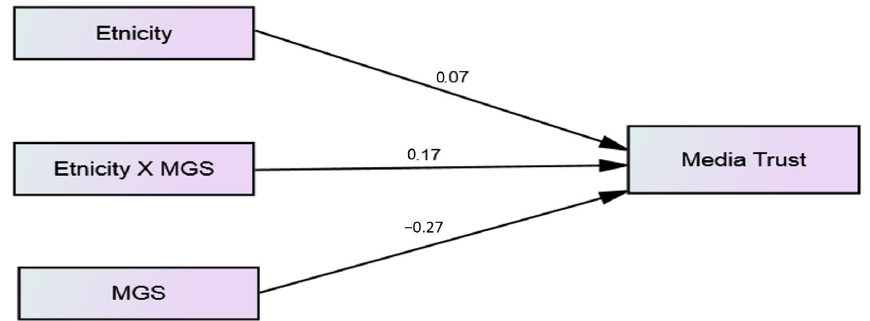
Figure 5. Moderation of Ethnicity in MGS and MT link.